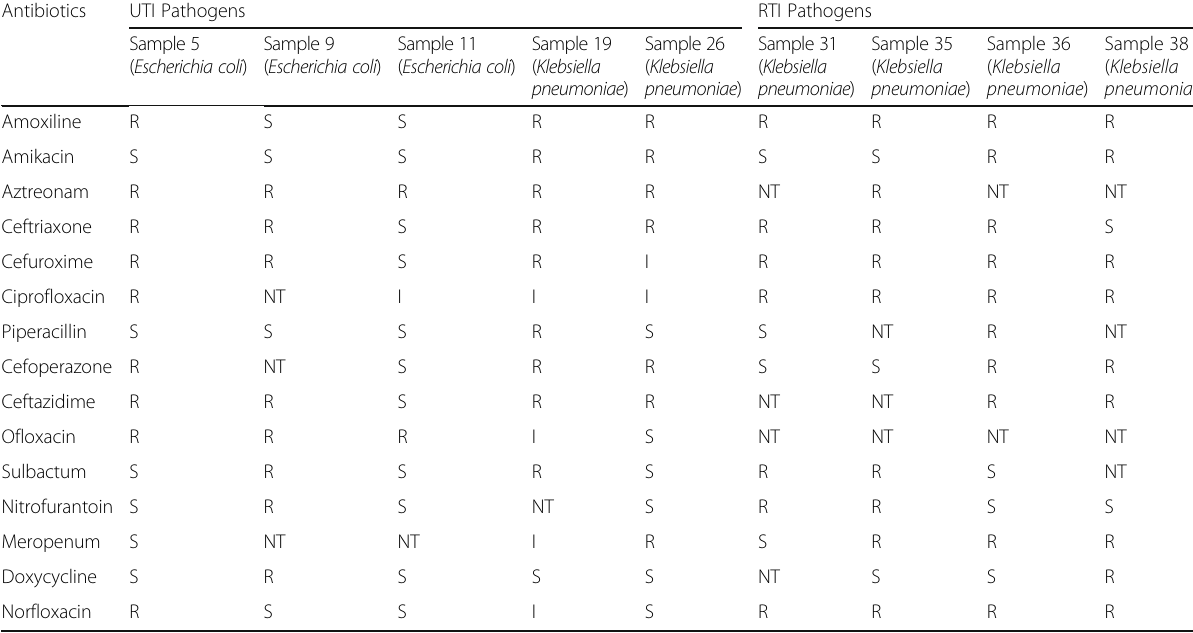
Table 1 Antimicrobial activities of nine clinical isolates of the human UTI and RTI bacteria against 15 well known drugs